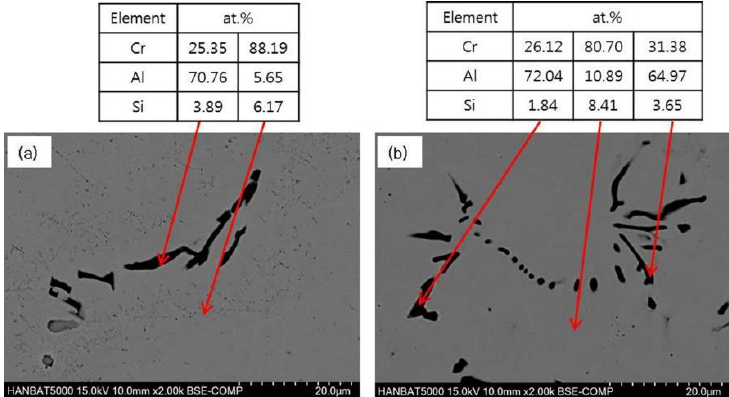
Figure 4. SEM-EDS analyses of isothermally heated Cr–xAl–5%Si alloys (2000X): ( a ) 5% Al, ( b ) 10% Al.